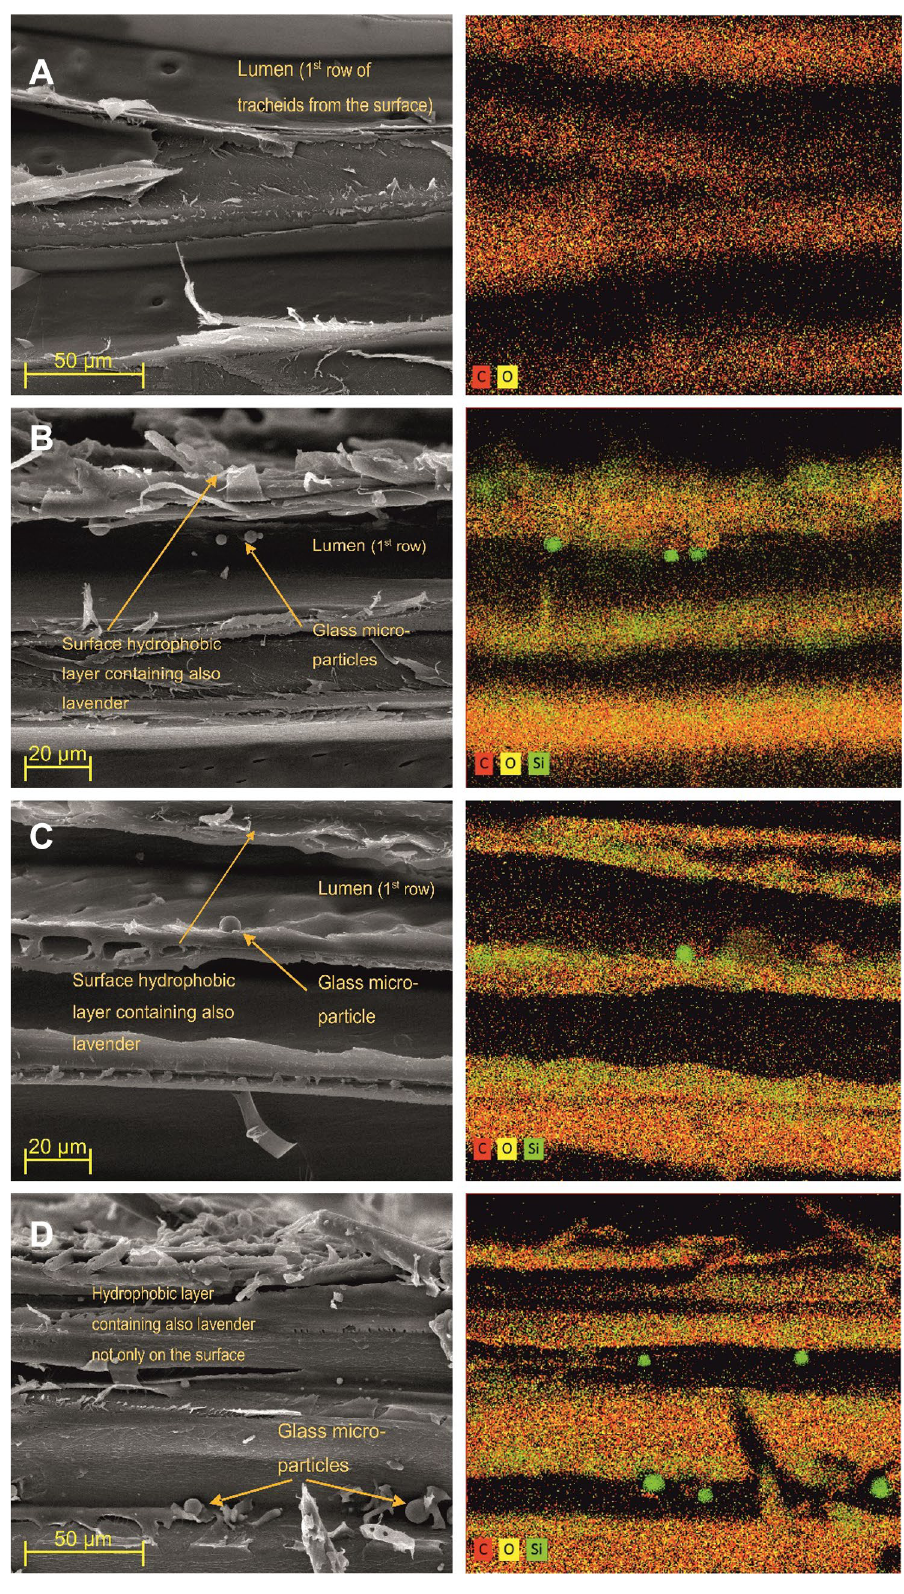
Figure 4. SEM micrograph (left) and the elemental composition analyses focused on Si (right) of the surface layer of spruce heartwood treated with lavender oil and a hydrophobic substance. The presence of higher concentrations of silane-siloxane compounds in cell wall structure and glass micro-particles on the surface and lumen of tracheid is shown—also after accelerated aging. ( A ) Lavender oil spruce wood treatment without aging and without hydrophobic layer 7; ( B ) Lavender oil treatment withou aging and with hydrophobic layer; ( C ) Lavender oil treatment with hydrophobic layer after leaching by water in accordance with EN 84; ( D ) Lavender oil treatment with hydrophobic layer after artificial weathering in